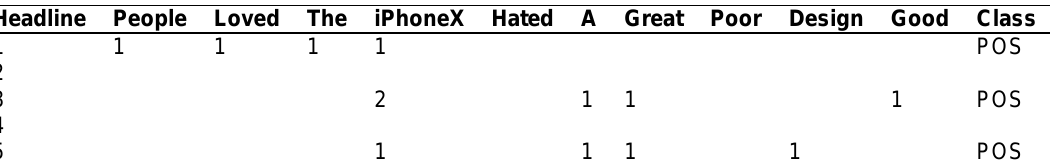
Table 3. Feature matrix of only positive classes